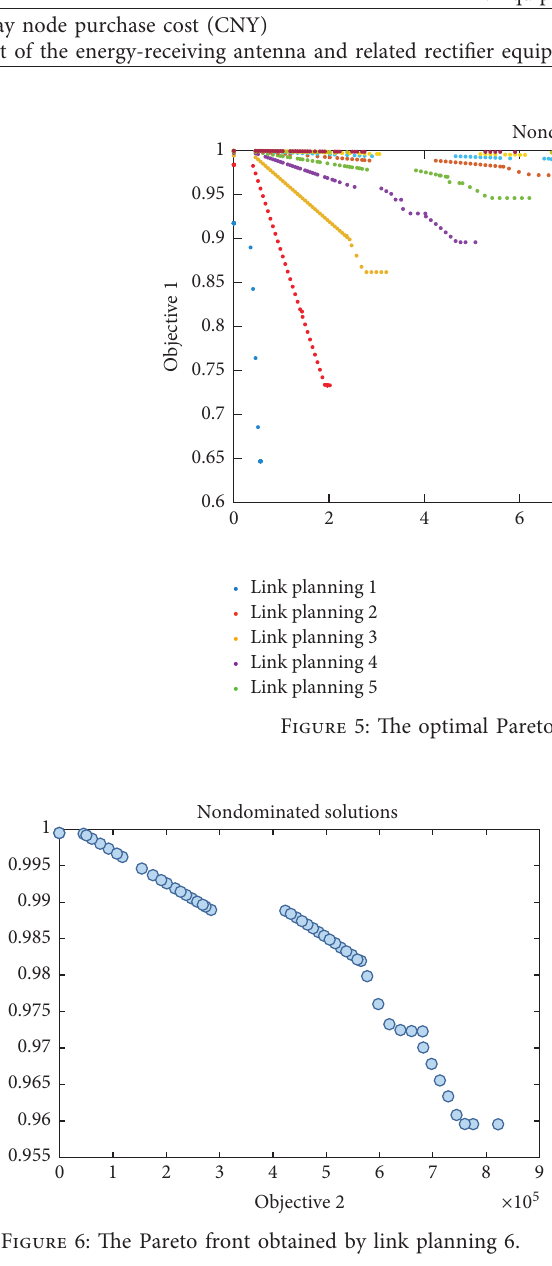
Table 2: Equipment cost parameters.